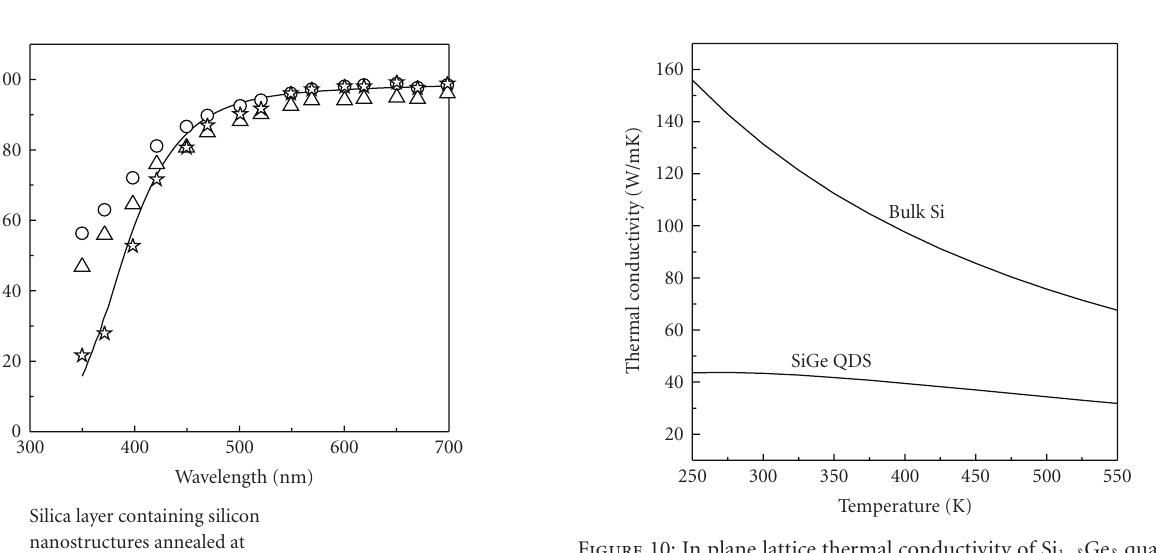
Figure 10: In plane lattice thermal conductivity of Si 1 − δ Ge δ quan- tum dot superlattice and bulk silicon as a function of temperature. The value of x is 0.05 and size of quantum dot is 4nm (from